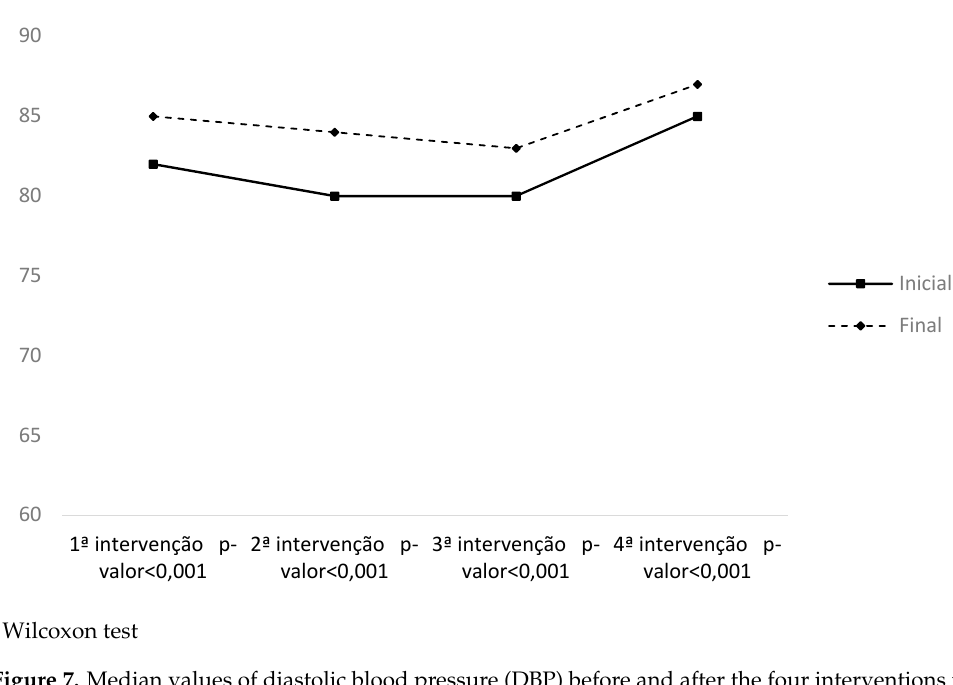
Figure 6. Median values of systolic blood pressure (SBP) before and after the four interventions in the CG (educational activity).